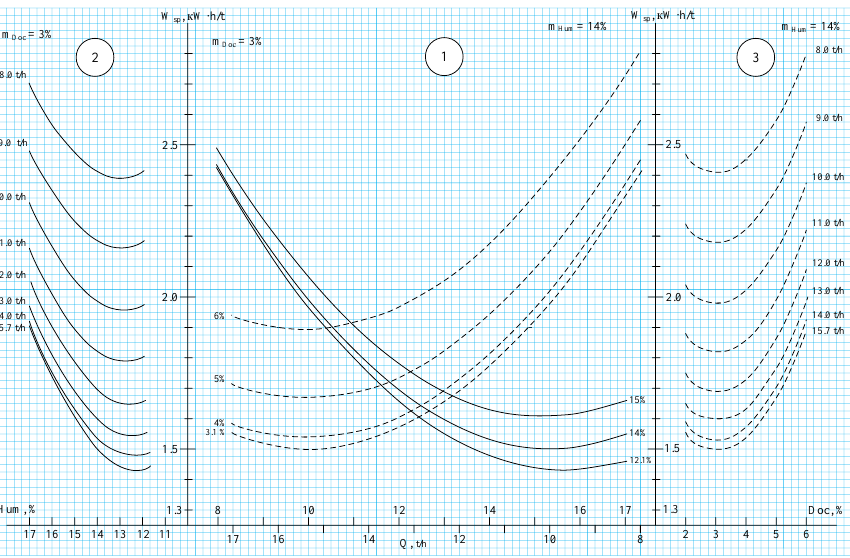
Figure 3. Nomograms of energy consumption for ZAV-20 (two production lines without disc separators).